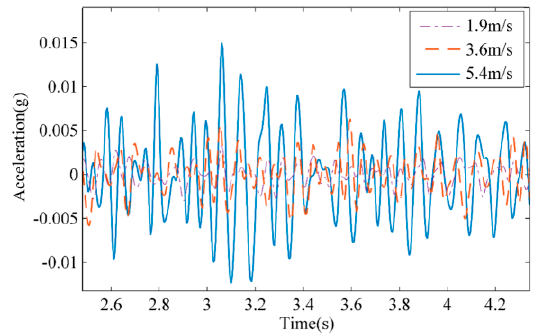
Figure 7. Acceleration of sensor 2 under different wind speeds.